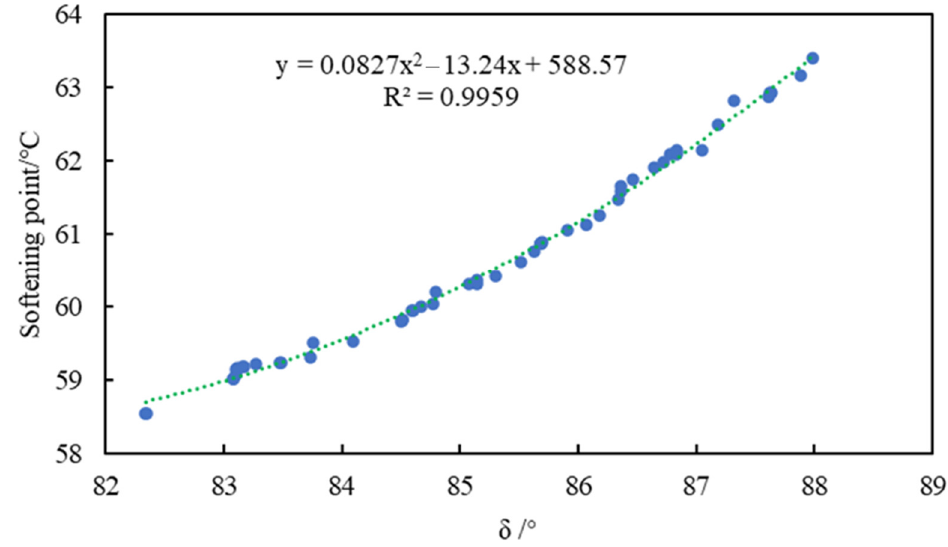
Figure 9. Pareto front.